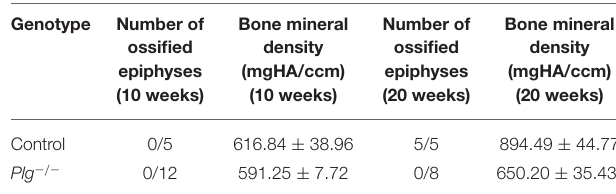
TABLE 1 | Quantification of the ossification of the proximal femoral epiphysis in mice with impaired